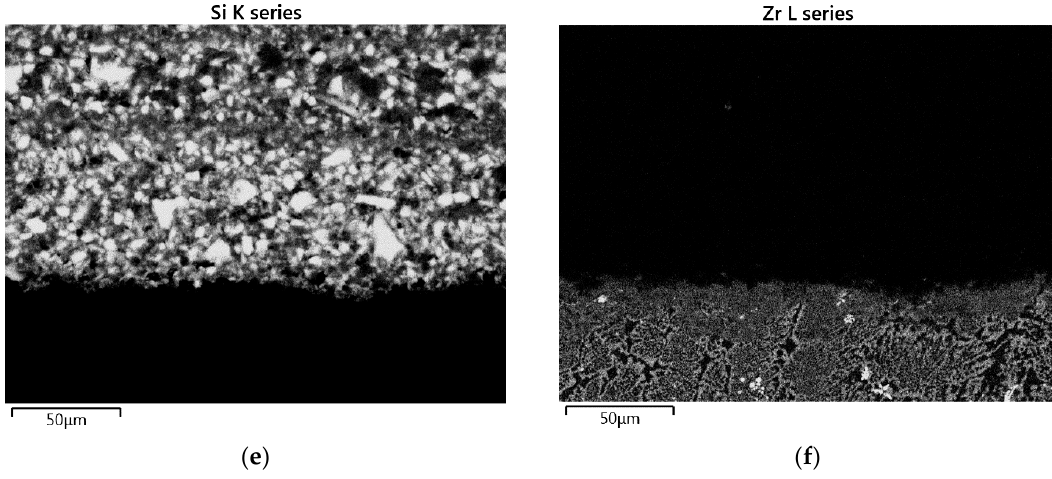
Figure 8. ( a ) SEM micrograph, and ( b – f ) EDS elements mapping of a PHPS/Si-B-coated Mo-14.8Zr-26B alloy after crosslinking, with pyrolysis at 1000 °C in nitrogen and oxidation testing at 800 °C in air.